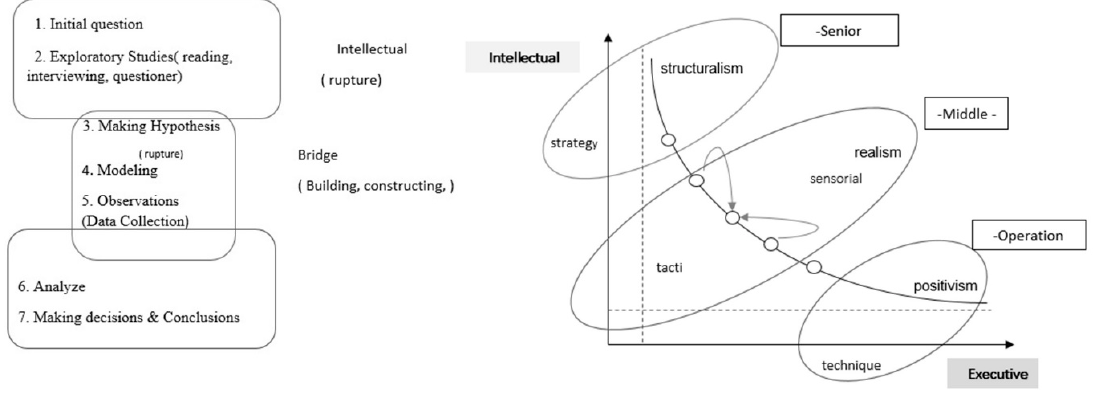
Figure 5. Revised diagram concerning Kiwi and Kampenhood methodology and its levels [31].